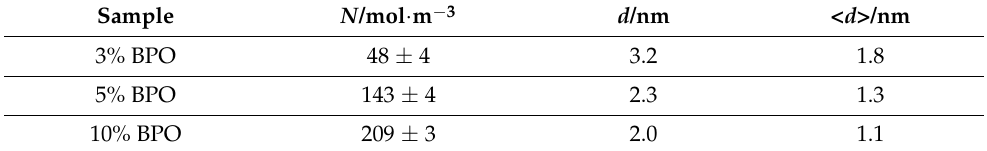
Table 2. The cross-link densities and estimated distances between cross-links for the studied PCL samples.